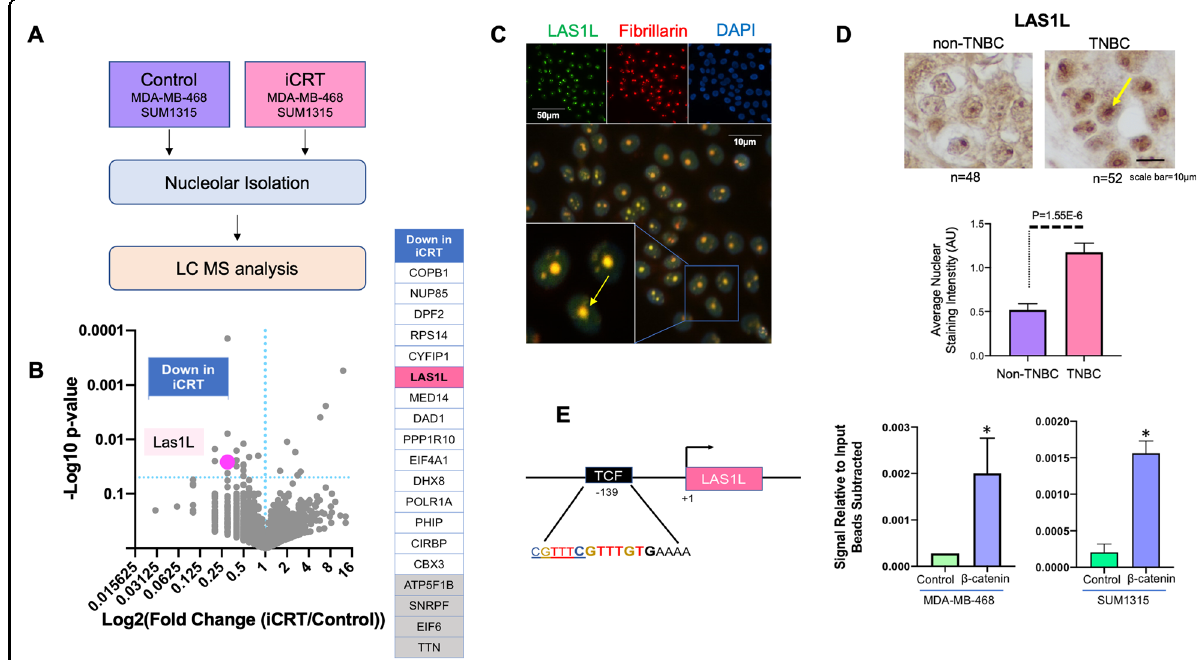
Fig. 4 Nucleolar protein LAS1L is a target of β -catenin signaling. A Schematics of work fl ow for TNBC cells treated with 5 µM iCRT14 for 48 h for nucleolar isolation and proteomic analysis. B Nucleolar proteome of TNBC cells (SUM1315 and MDA-MB-468) was compared with and without iCRT14 treatment. Volcanoplot reveals 19 proteins (listed) signi fi cantly reduced in nucleoli of TNBC cells after iCRT14 treatment. Special attention is drawn to LAS1L, the only protein found to be signi fi cantly altered in both TNBC vs. non-TNBC proteomics as well as the iCRT14 nucleolar proteomics. C Immuno fl uorescent staining of LAS1L and Fibrillarin verifying the presence of LAS1L is a nucleolar protein in TNBC cells. D Immunohistochemical staining of TNBC vs. non-TNBC tumor samples for LAS1L veri fi es a signi fi cant increase in LAS1L staining in the TNBC tumor samples compared to Non-TNBC tumor samples. Statistical signi fi cance was determined by T -test and error bars to represent SEM. E Diagrammatic representation of the predicted TCF consensus sequence in the promoter region of the LAS1L gene. Is a tandem overlap of two TCR/LEF sites. CCTTTGAAC is the most preferred TCF/LEF binding cite 49 . Most conserved bases are indicated with red color. Bases less conserved are indicated with blue and yellow colors. ChIP-qPCR analysis of β -catenin bound to the TCF consensus sequence in the promoter of the LAS1L gene. Statistical signi fi cance was determined by T -test and error bars to represent